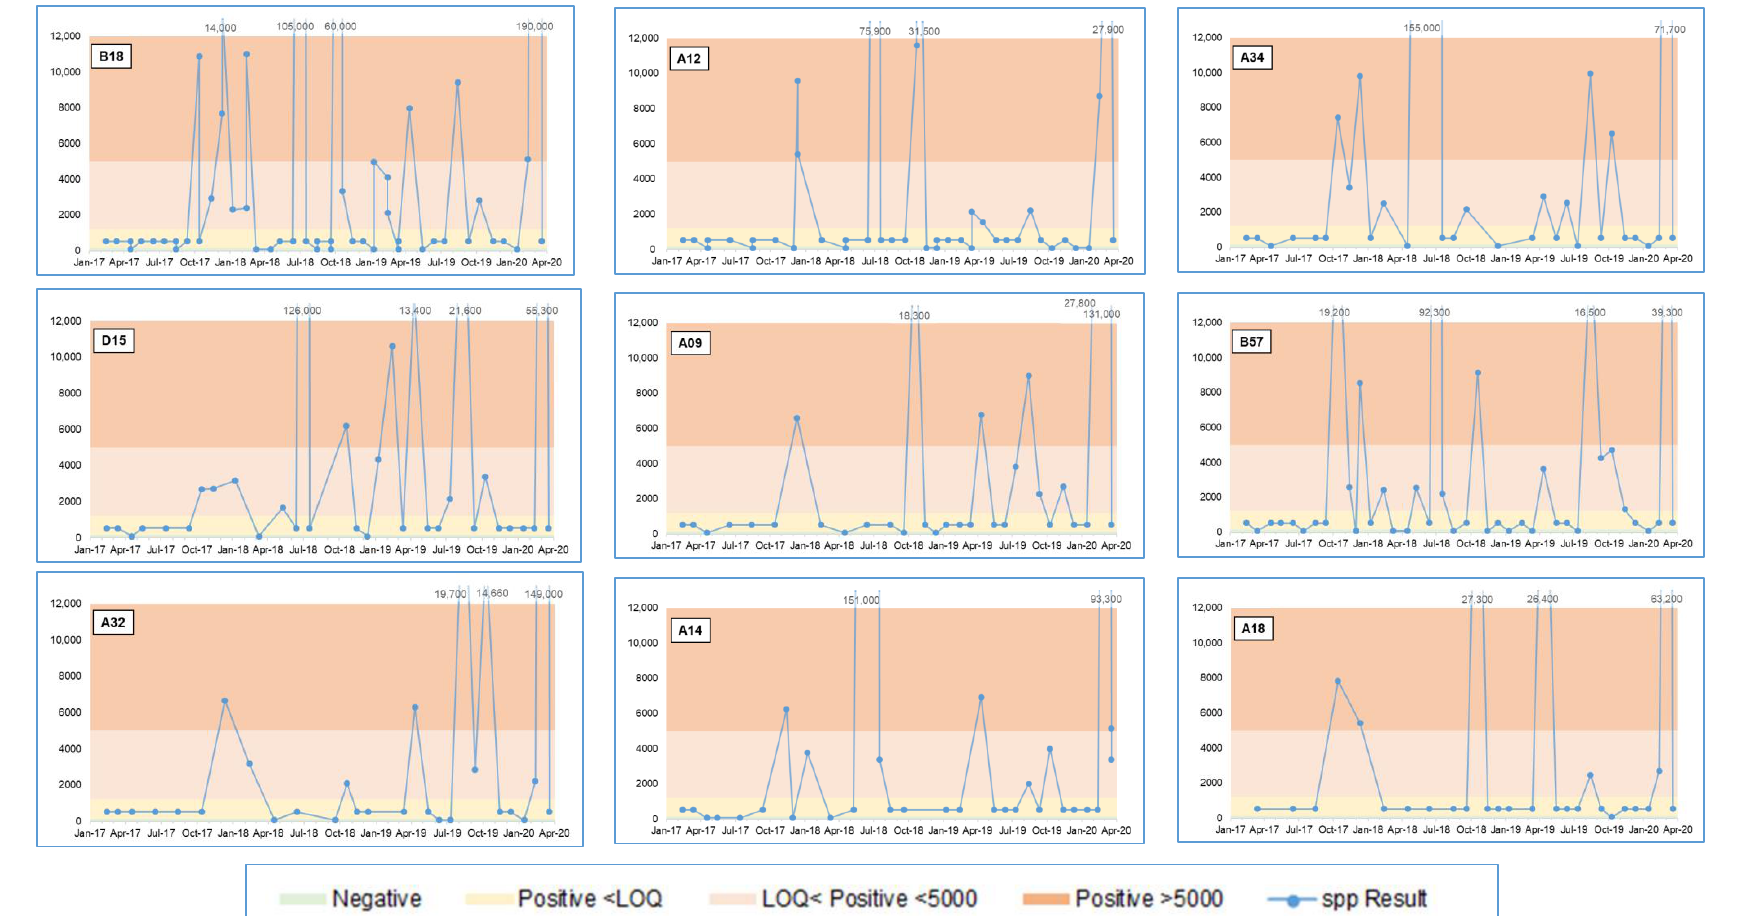
Figure 5. Legionella spp. qPCR data over three years for nine locations in Factory 2 with the greatest number of >5000 GU/L results.